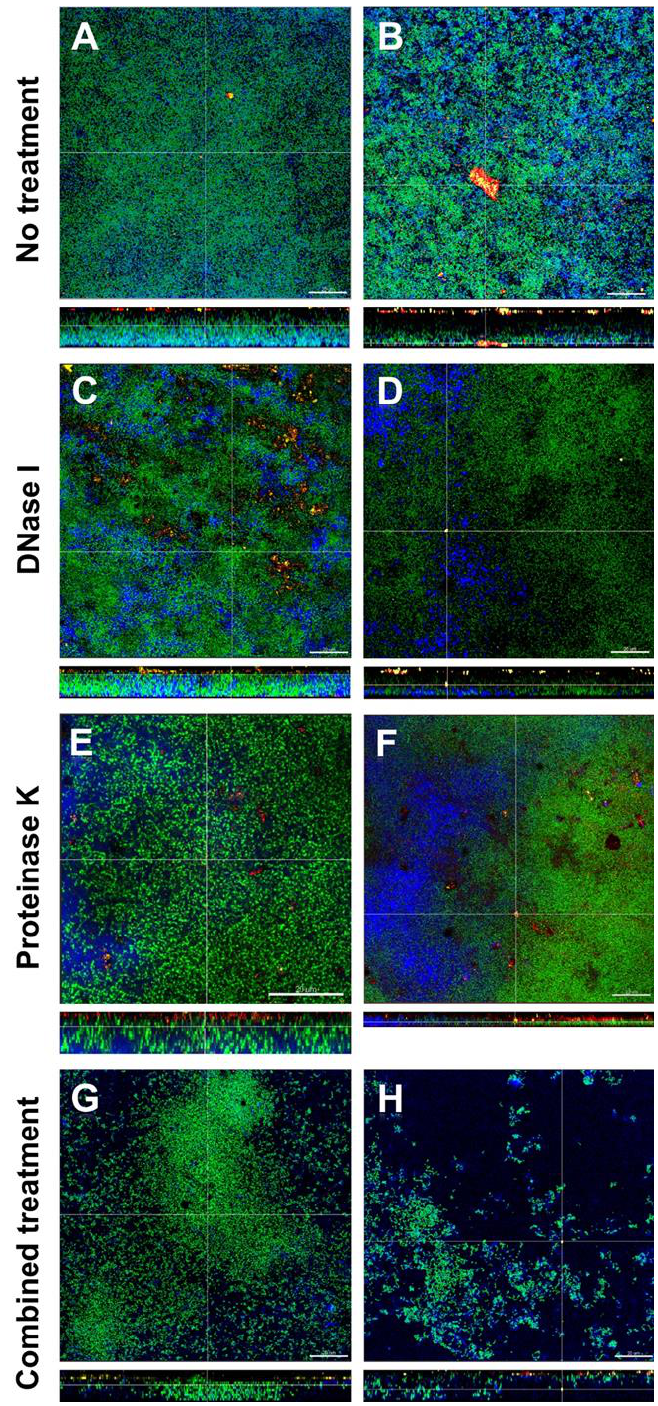
Figure 3. Representative confocal laser scanning microscopy (CLSM) images of six-species oral biofilms after no treatment ( A,B ), or exposure to 0.001 mg/mL DNase I ( C ), 0.002 mg/mL DNase I ( D ), 0.05 mg/mL proteinase K ( E ), 0.1 mg/mL proteinase K 0.1 mg/mL ( F ), or combined treatment with 0.001 mg/mL DNase I and 0.05 mg/mL proteinase K ( G ), or with 0.002 mg/mL DNase I and 0.1 mg/mL proteinase K ( H ), respectively. Bacteria appear green due to DNA-staining with Yo Pro 1/Sytox Green; extracellular polysaccharides are stained blue with calcofluor; extracellular DNA appear red after staining with anti-DNA antibodies and streptavidin (Cy3); extracellular proteins appear yellow due to Sypro TM Ruby. The biofilm base in the cross sections is directed towards the top view. Scale = 20 µm.